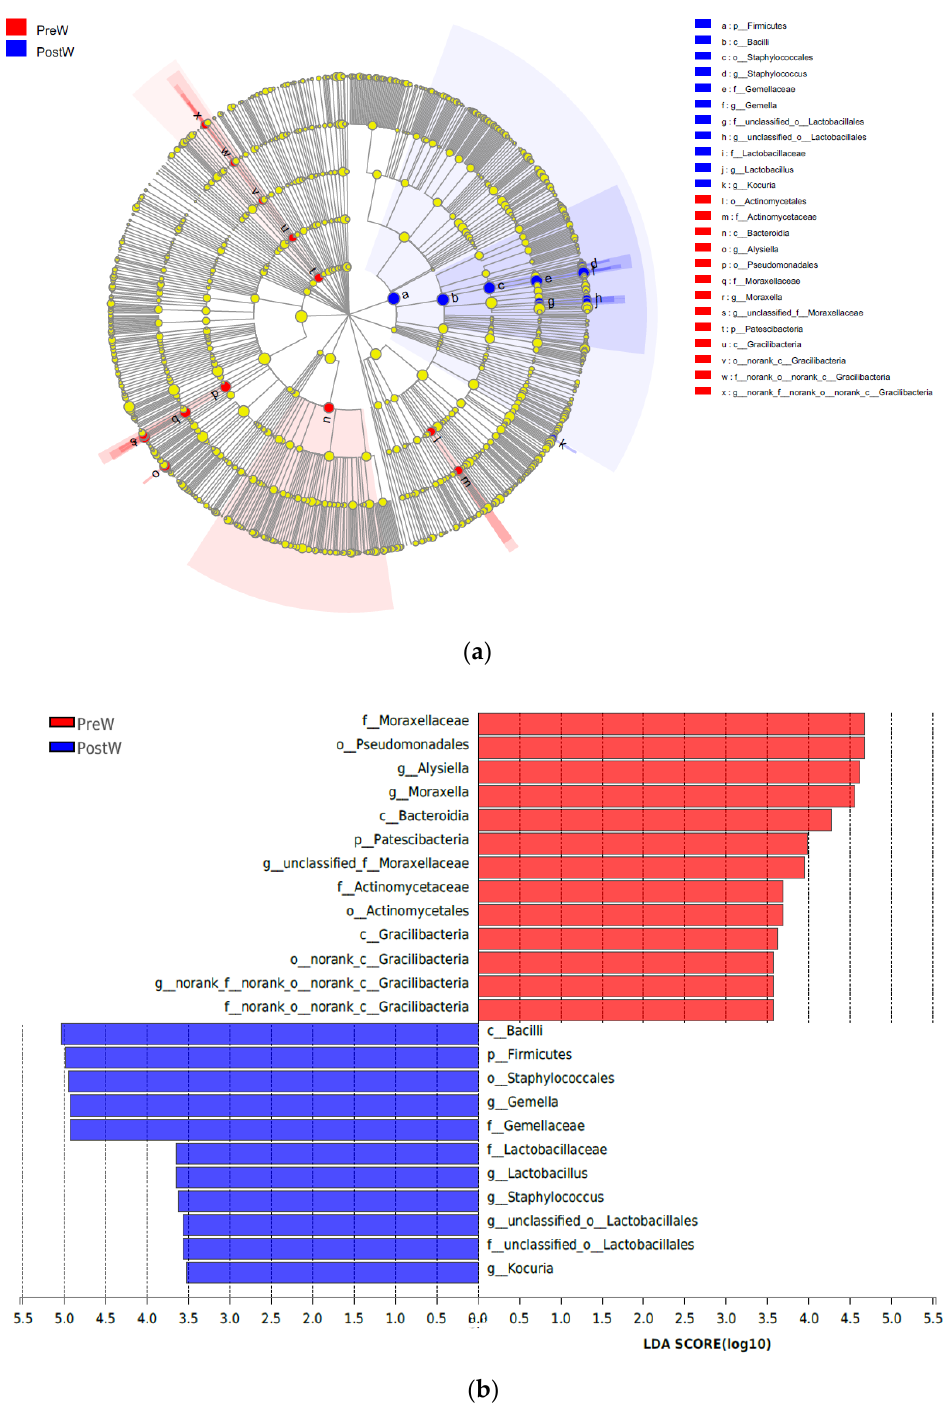
Figure 7. LEfSe analysis of the oral microbial composition of Dezhou donkeys in preweaning and postweaning stages. ( a ) Cladogram by the LEfSe method, visualizing the phylogenetic distribution of the oral bacteria. ( b ) Histogram of the LDA scores, showing the most differentially abundant taxa between two groups (LDA score > 3.5, n = 10). PreW, preweaning group; PostW, postweaning group.